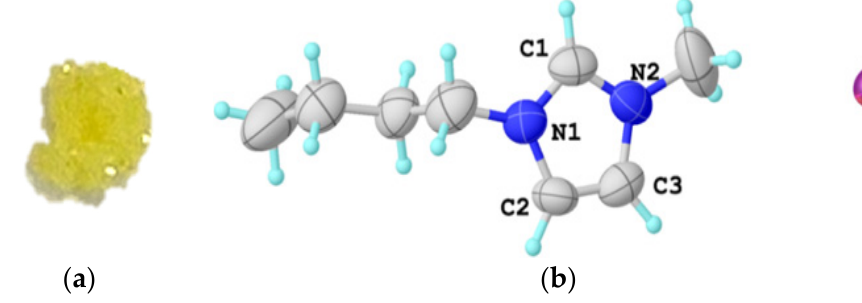
Figure 5. ( a ) Crystal precipitated after reaction; ( b ) composition of crystal.